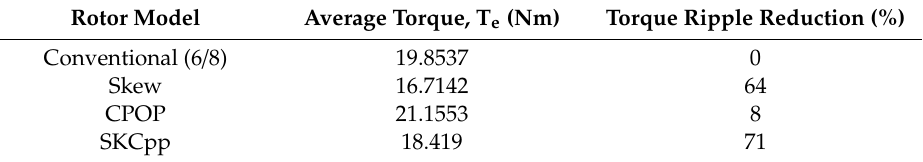
Figure 28. Comparisons of a torque ripple effect for various methods at transient load. Table 6. Comparison table of reduction of torque ripple for NRE-PM FRM at TR-rated-load.